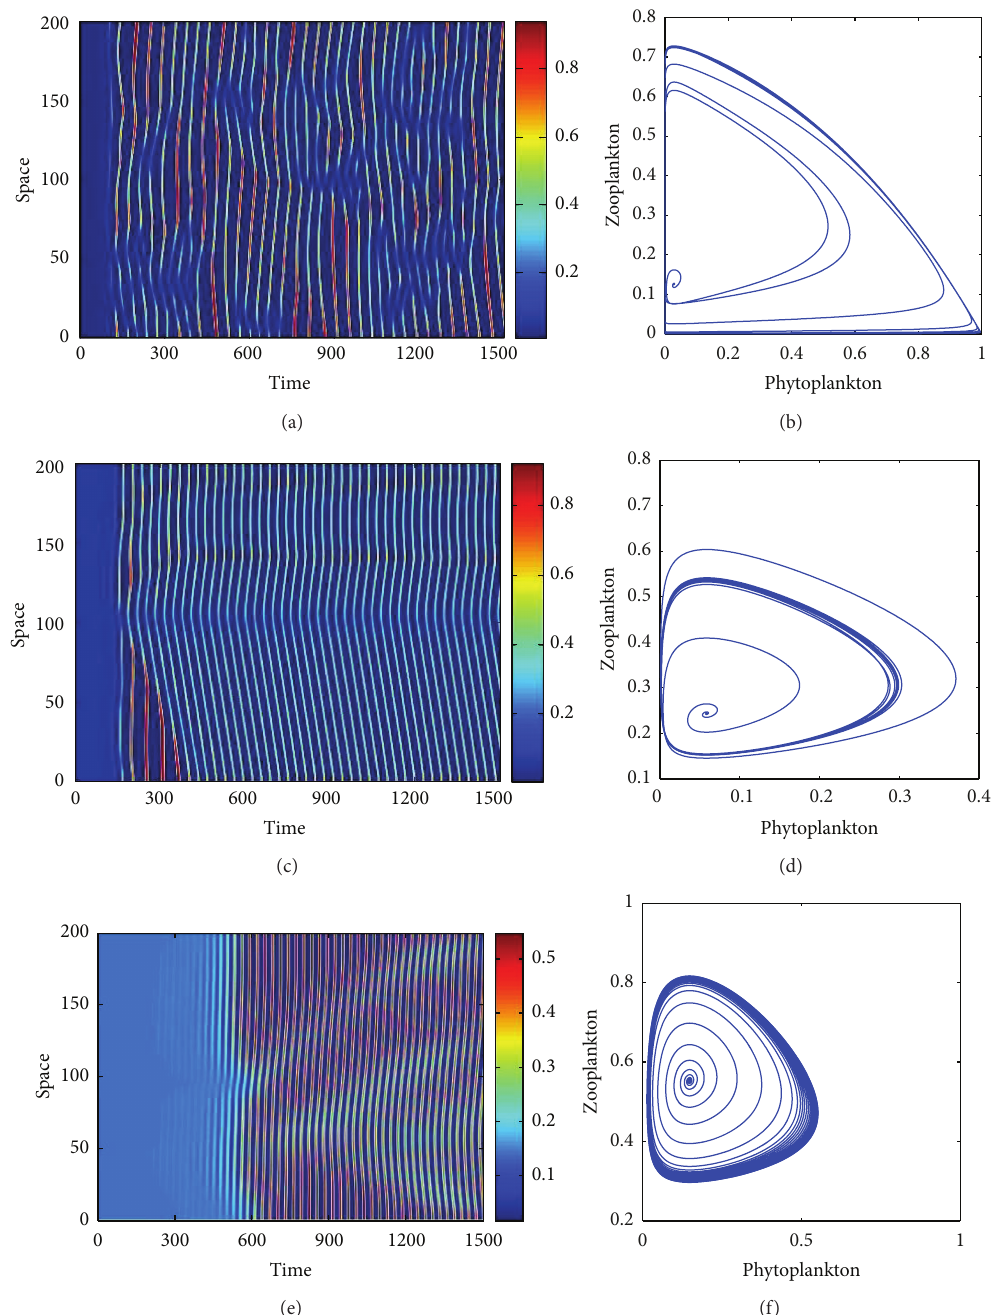
Figure 2: Spatiotemporal dynamics of model (3). ((a), (c), (e)) phytoplankton (2-D), ((b), (d), (f)) phase diagram. This analysis used the same set of parameter values as Figure